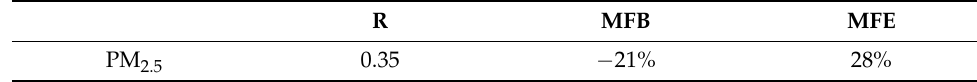
Table 2. Statistical indicators of Bozhou CMAQ model evaluation in January 2017.